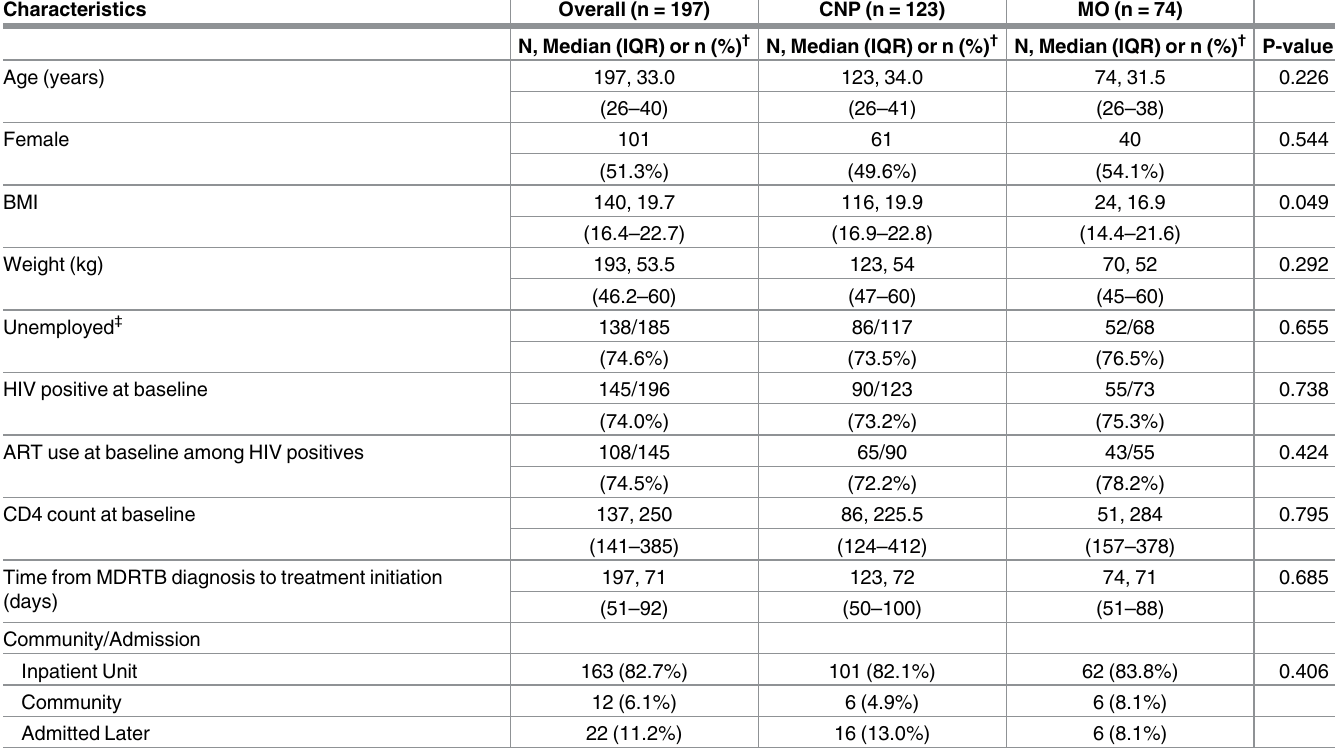
Table 1. Patient characteristics by provider